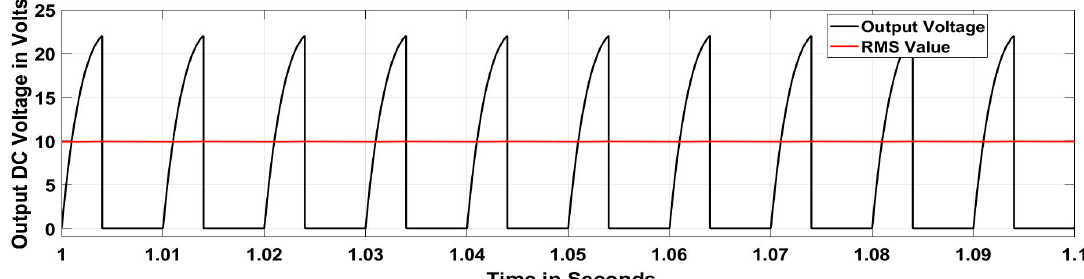
Figure 12. Simulink simulation of control pulse for DC–DC boost mode.